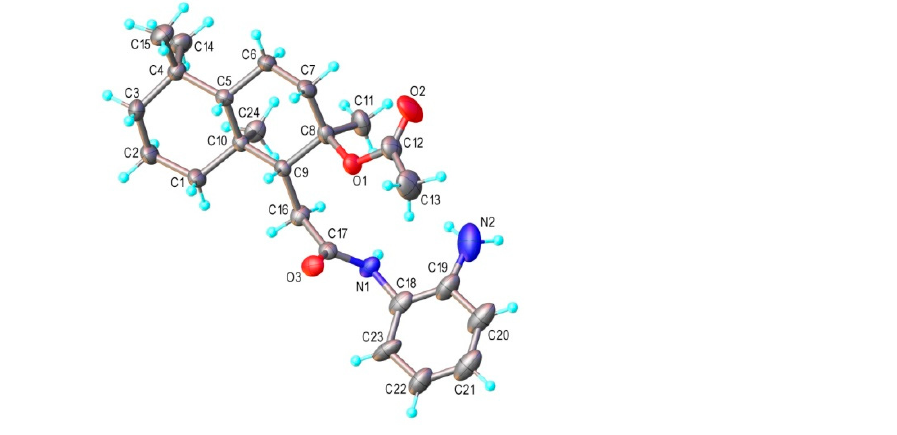
Figure 2. X-ray molecular structure of compound 20, with atoms labeling and thermal ellipsoids at 50% level.